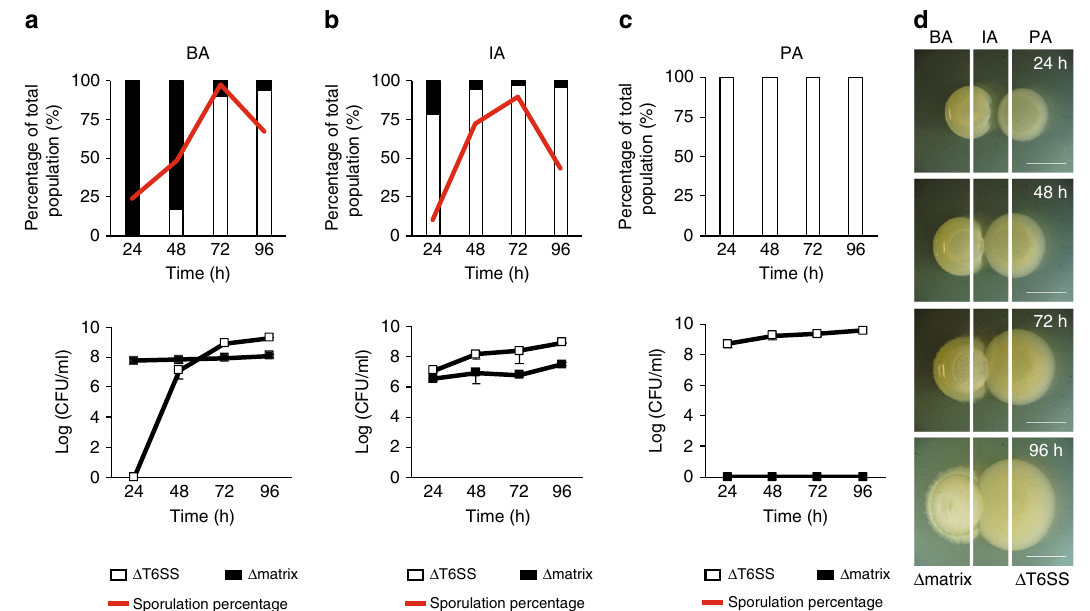
Fig. 7 T6SS affects B. subtilis sporulation. a – c panels show (upper part) percentages and (bottom part) Log (CFU/ml) of Δ T6SS (empty bars and squares) and Δ matrix (black bars and squares) in three different sections (BA [ Δ matrix area], IA [Intermediate area], and PA [ Δ T6SS area]) of the interaction at different time-points (24 h, 48 h, 72 h, 96 h). Sporulation rates are shown as red lines. d Scheme of the interactions and the sections: BA ( Δ matrix area), IA (Intermediate area), and PA (PCL1606 area). Scale bar = 5 mm. Cells from the three sections of the interaction were collected, sonicated and completely resuspended, diluted and plated to determine colony-forming units (CFU), sporulation rates and percentages of each species over the total bacterial population in the interaction. Average values of three biological replicates are shown, with error bars representing SD. Source data are provided as a Source Data fi